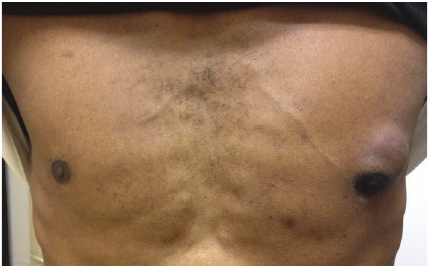
Figure 1: Subcutaneous mass invading left breast tissue (from previous admission).